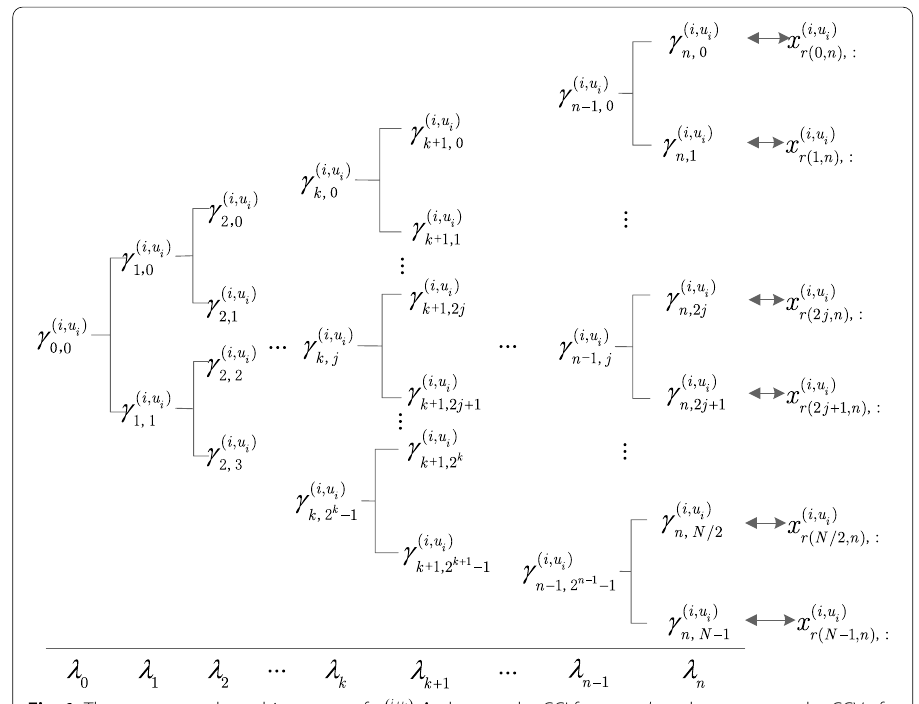
Fig. 1 The common column binary tree of x ( i , u i ) : (cid:31) k denotes the CCI for stage k , and γ represents the CCV of x ( i , u i